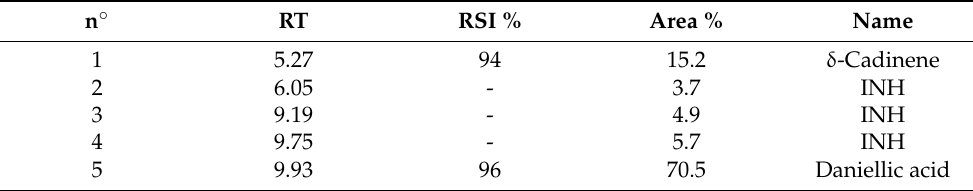
Table 5. GC-MS results of dichloromethane fraction of D. oliveri roots. n ◦